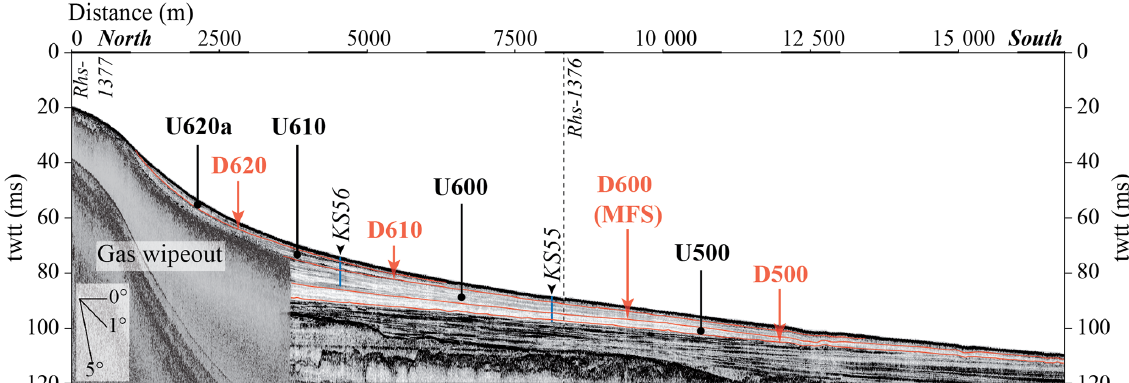
Figure 2. “Dip” (NS) chirp seismic profile across the Grand Passon and Bras de Fer subaqueous delta (position in Fig. 1). Surface D500 corresponds to the flooding surface (which coincides here with a wave ravinement surface) that separates the Younger Dryas (seismic unit U400) deposits from the Preboreal deposits (seismic unit U500). The downlap surface D600 is the maximum flooding surface formed during the turnaround between retrogradation and progradation. D610 and D620 are erosional surfaces that mimic flooding surfaces and separate the middle and late Holocene sedimentary wedges (seismic units U600, U610, and U620a) formed in response to the successive shifts of Rhône Channel. Twtt: two-way travel time.